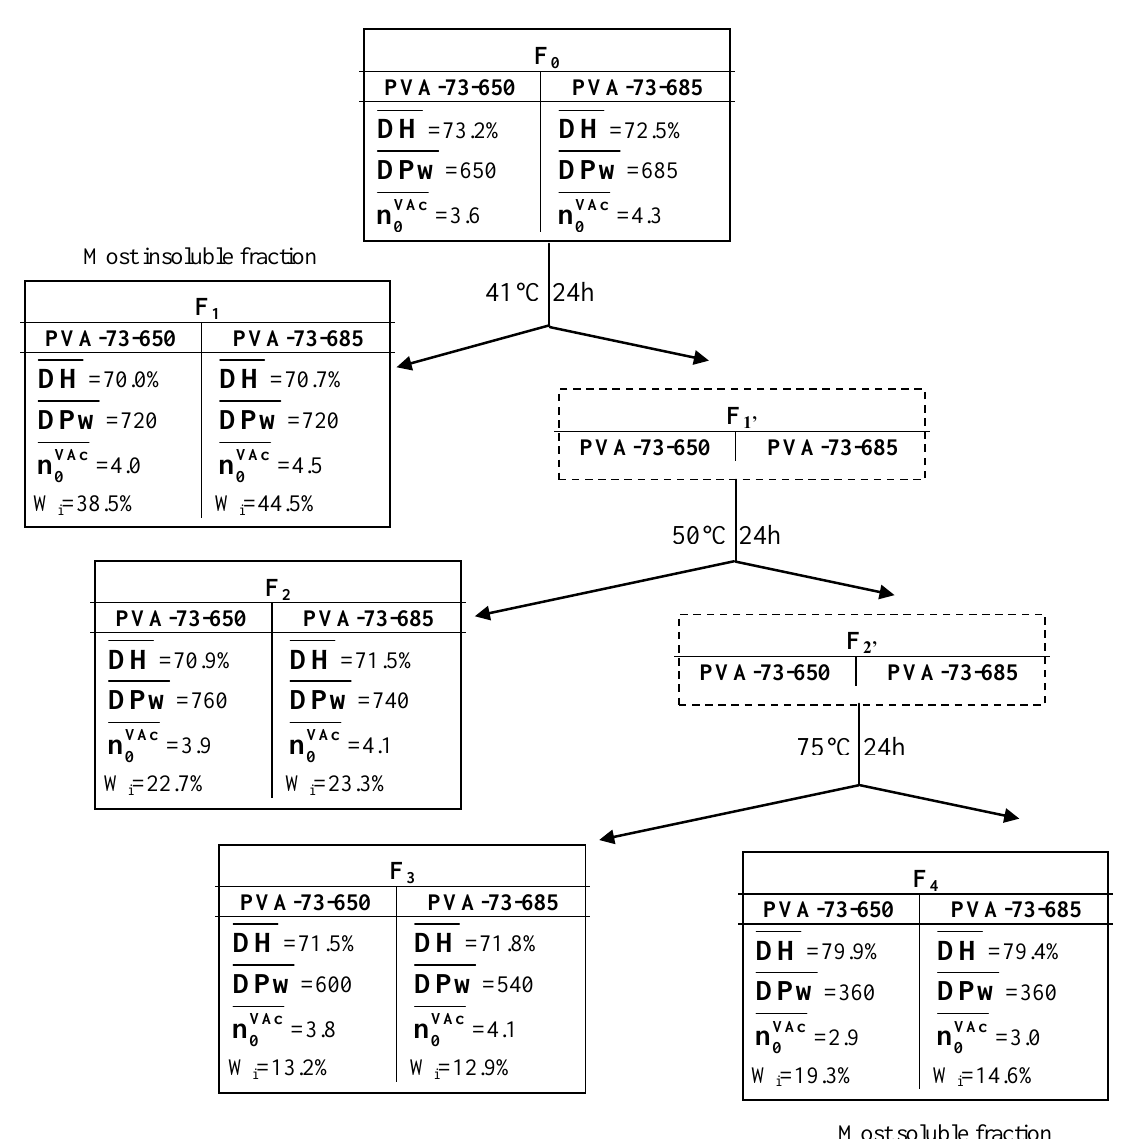
Figure 2. Schematic representation of the different fractionation steps. Molecular characteristics of the phases in equilibrium for sample PVA-73-650 and PVA-73-685 with DH -average degree of hydrolysis, DPw -weight average degree of polymerization, VAc n -average sequence length of vinyl acetate and W 0